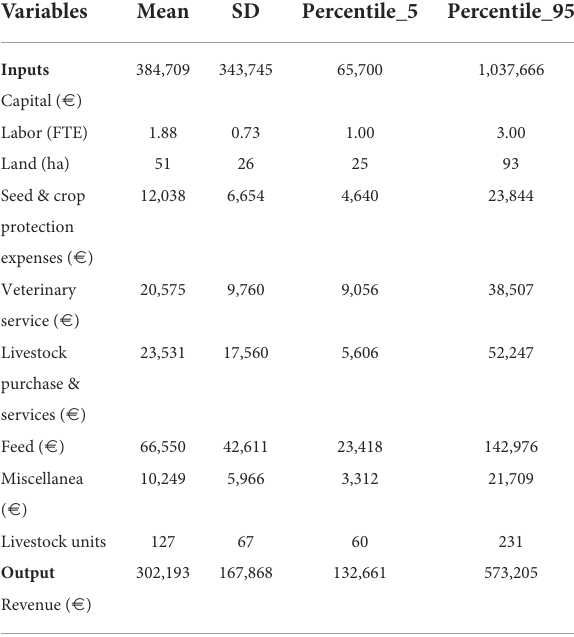
TABLE 2 Descriptive statistics of the selected DEA variables based on the herd data ( n = 7,782) from 2007 to